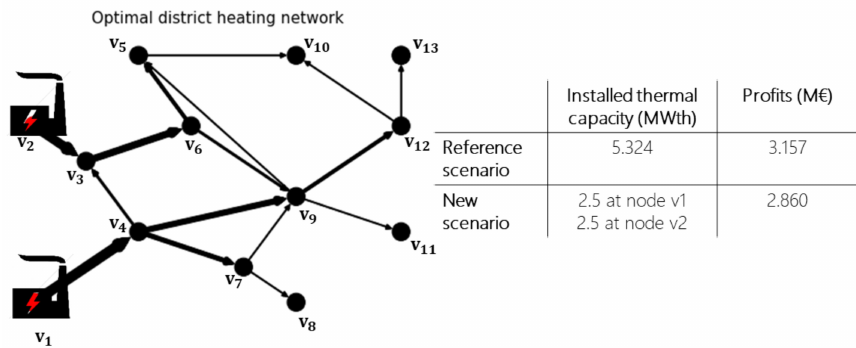
Figure 13. Influence of the limitation of the heating capacities of the power